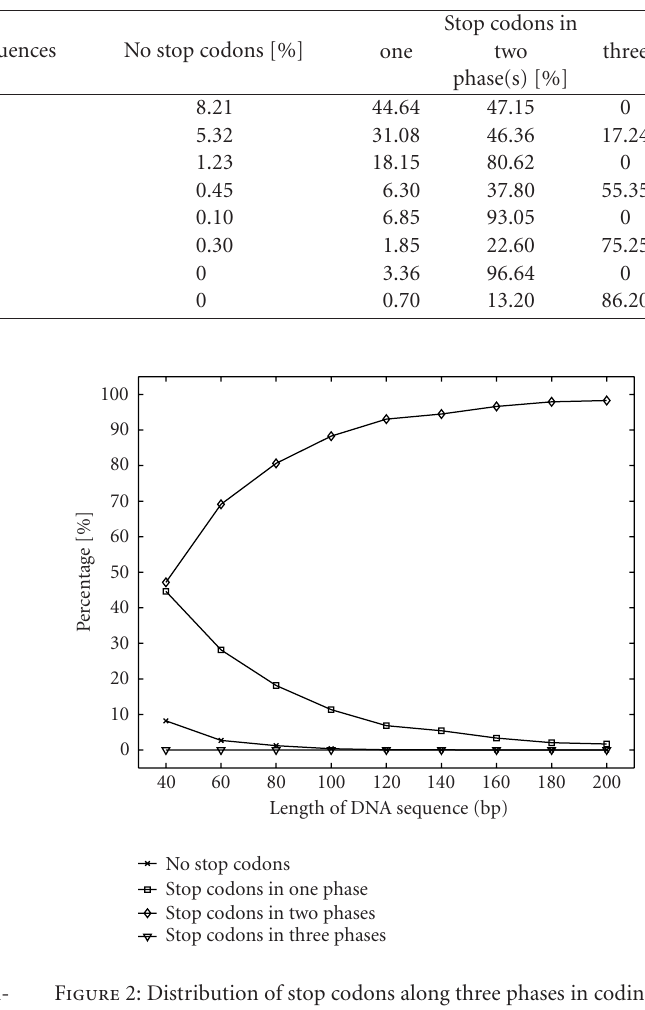
Table 1: Distribution of stop codons along phases for coding and noncoding DNA regions.